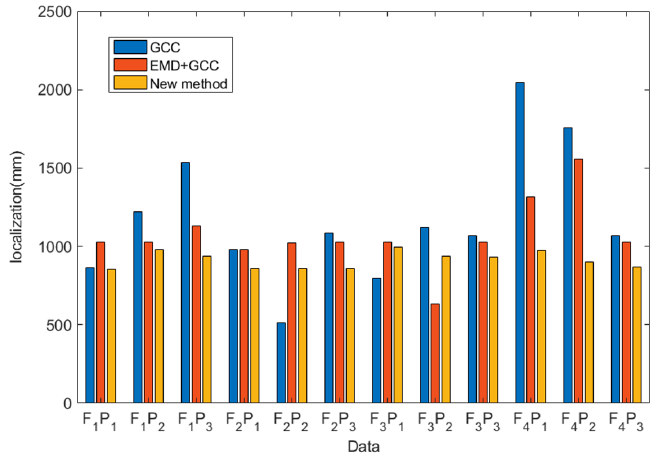
Figure 13. Leak localization with the tested methods.